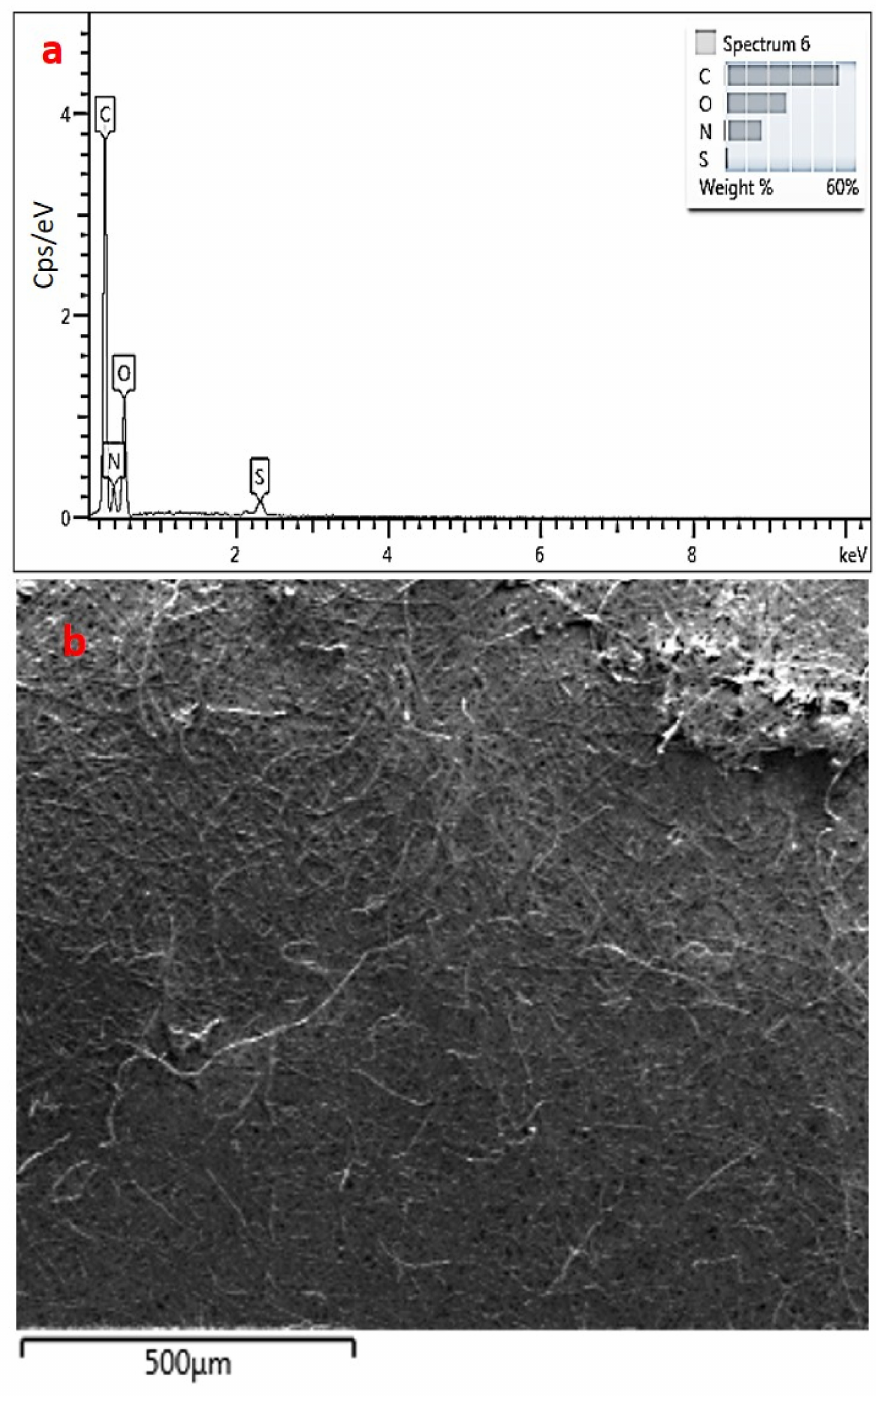
Figure 10. ( a ) EDS analysis of OLE-loaded eggshell membrane; ( b ) SEM image of the OLE-loaded eggshell